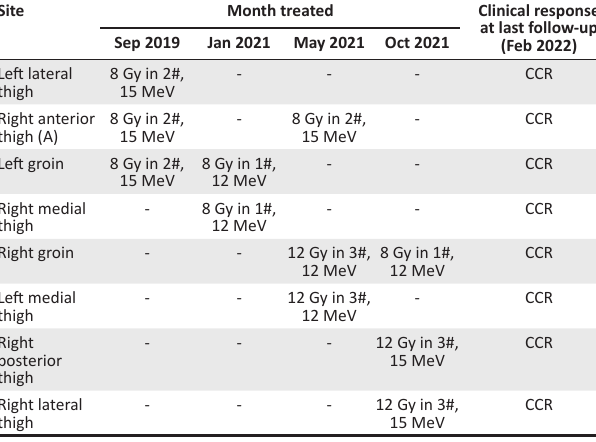
TABLE 1: Sites of nodular lesions, dates treated (and retreated) and clinical response at 4 months post radiotherapy. Site Month